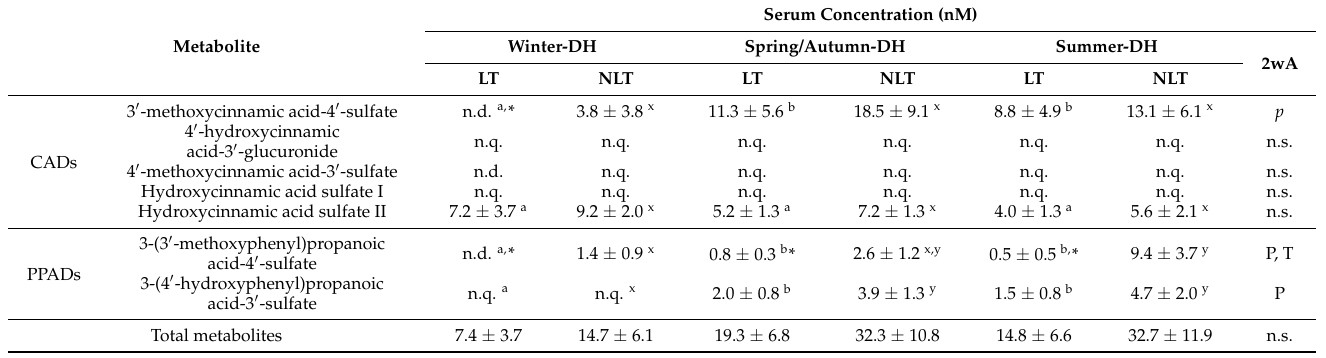
Table 2. Tomato-derived (poly)phenolic metabolites in serum of rats exposed to three seasonal daylight schedules after ingestion of 100 mg/kg bw/day local (LT) and non-local (NLT) Ekstasis tomatoes. Results are expressed as the mean values in nM ± SEM ( n =